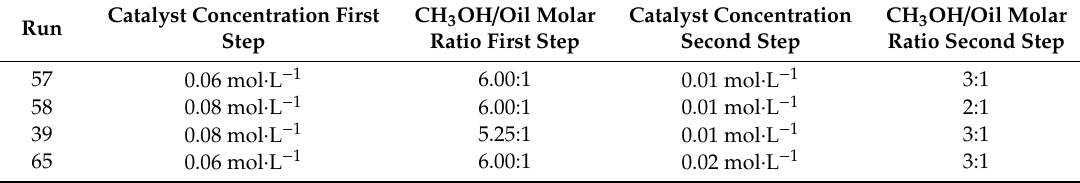
Figure 2. Annual variable cost in millions of dollars for the selected conditions. Table 4. Experimental conditions with the lowest variable costs per liter of biodiesel.